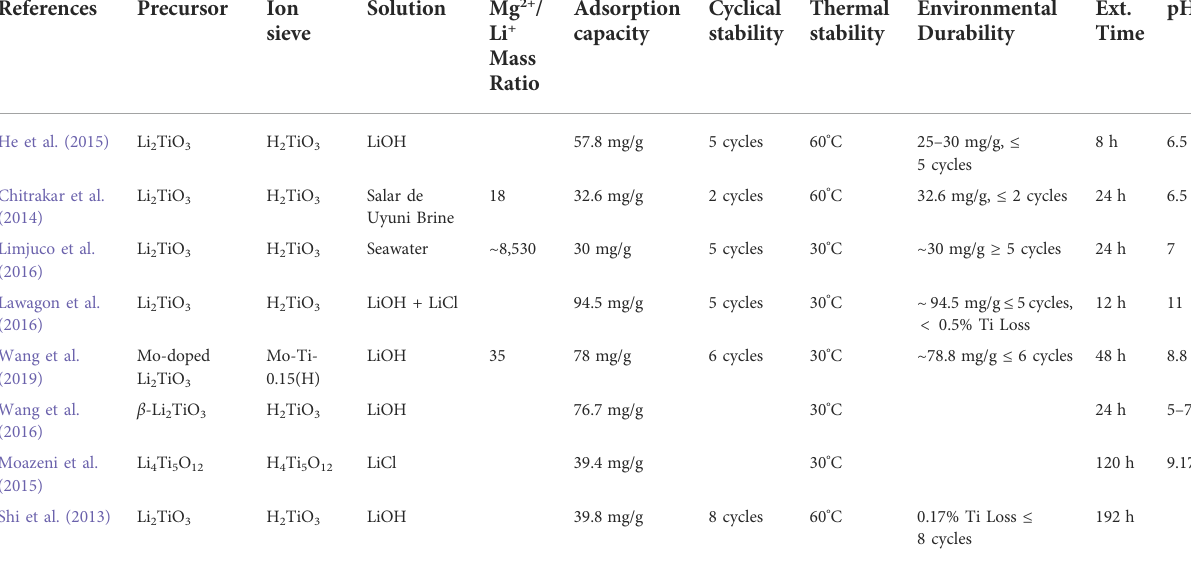
TABLE 7 Li + LTO-Type LIS extraction from salt lake brines, simulated brines, and